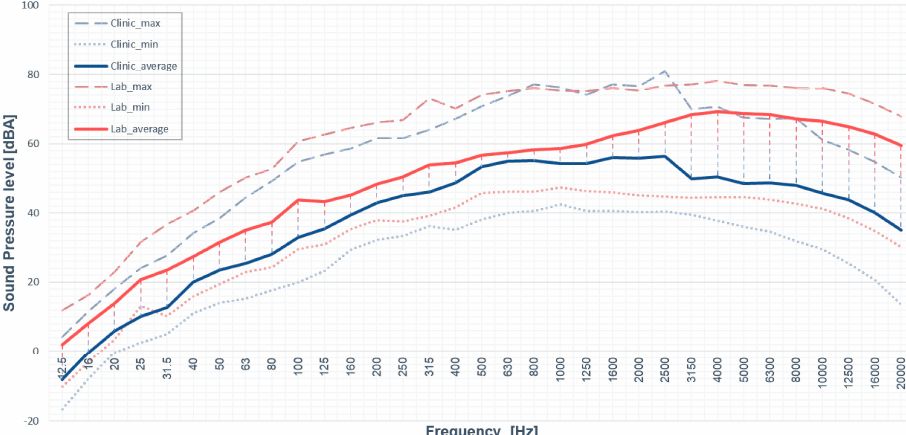
Figure 1. A plot of the maximum, minimum, and average A-weighted sound pressure level of the noise at the dental clinic and the dental laboratory in 1/3-octave band